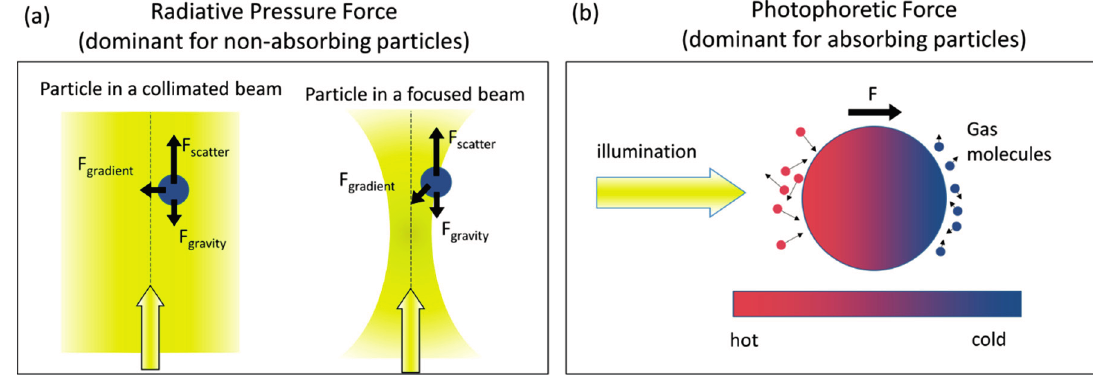
Figure 1. ( a ) The radiative pressure force, which is the dominant force experienced by non-absorbing particles, results from the transfer of momentum from photons scattered by a particle. The radiative pressure force can be divided into a scattering force, which tends to push the particle along the direction of light propagation, and a gradient force, which tends to pull the particle toward the highest intensity region. The gradient force enables trapping in a focused laser beam; ( b ) The photophoretic force, which is the dominant force experienced by strongly absorbing particles, results from the transfer of heat to surrounding gas molecules from a non-uniformly heated and/or non-uniformly heat-emitting